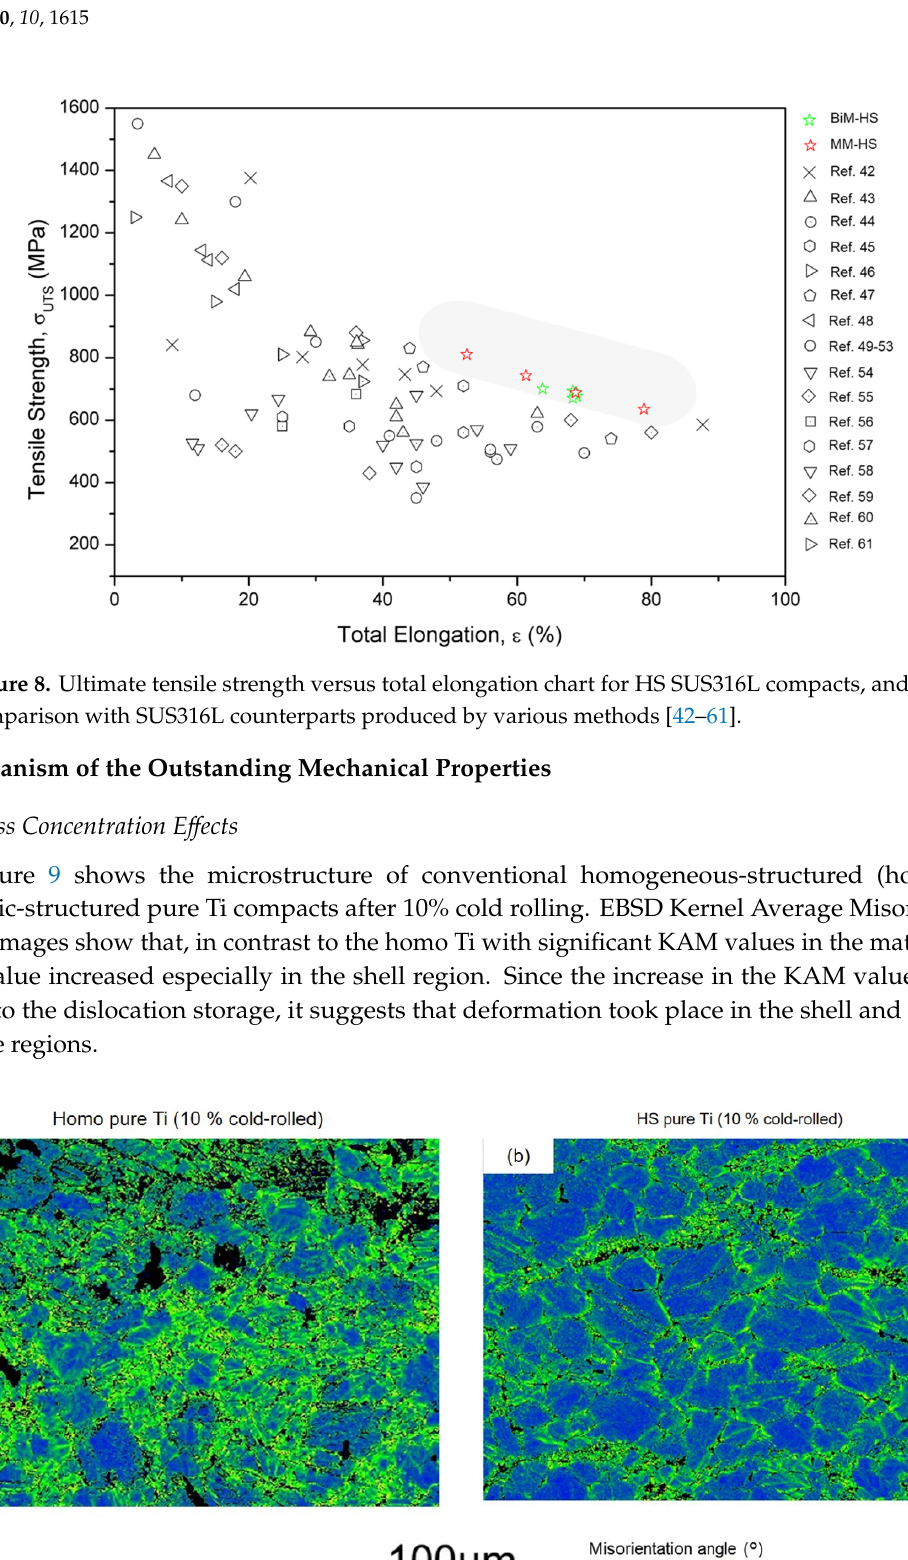
Figure 7. Tensile engineering stress-strain curves of harmonic structured SUS316L compacts developed through BiM and MM processes.